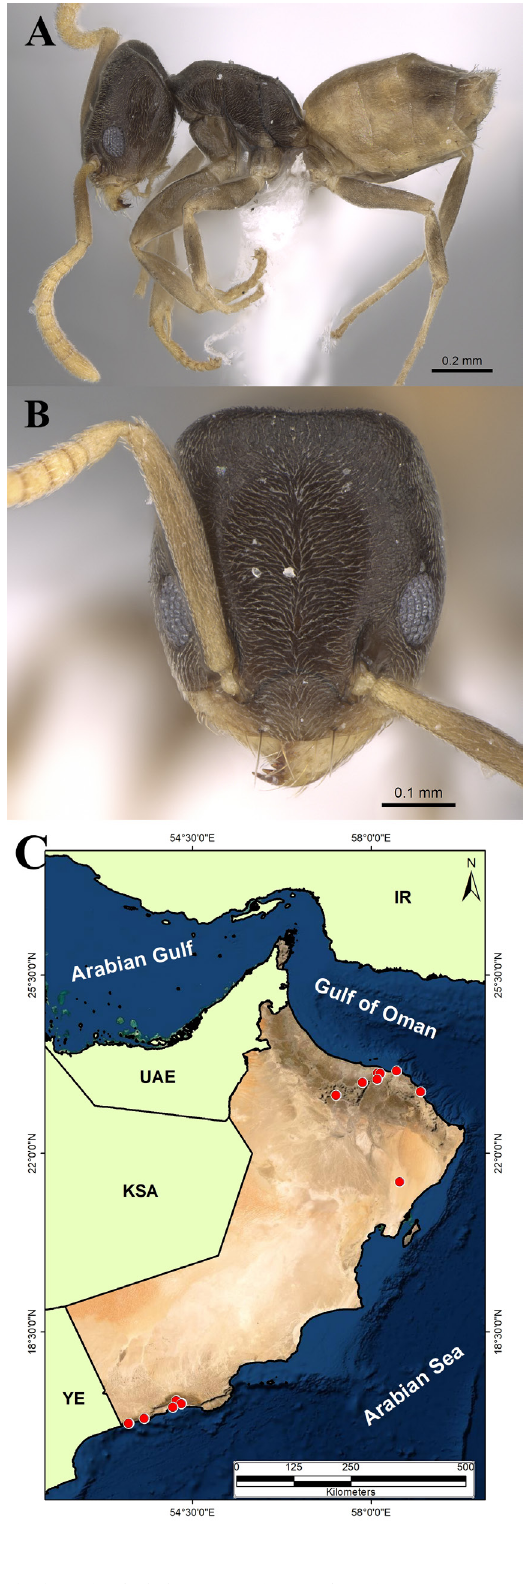
Fig. 2. Tapinoma melanocephalum (Fabricius, 1793), worker (CASENT0922866, AntWeb.org (Michele Esposito)). A . Body in profile. B . Head in full-face view. C . Distribution